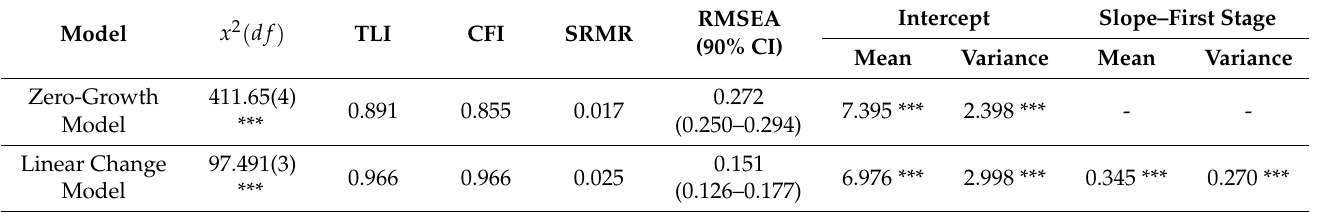
Table 6. Model fit of job performance.